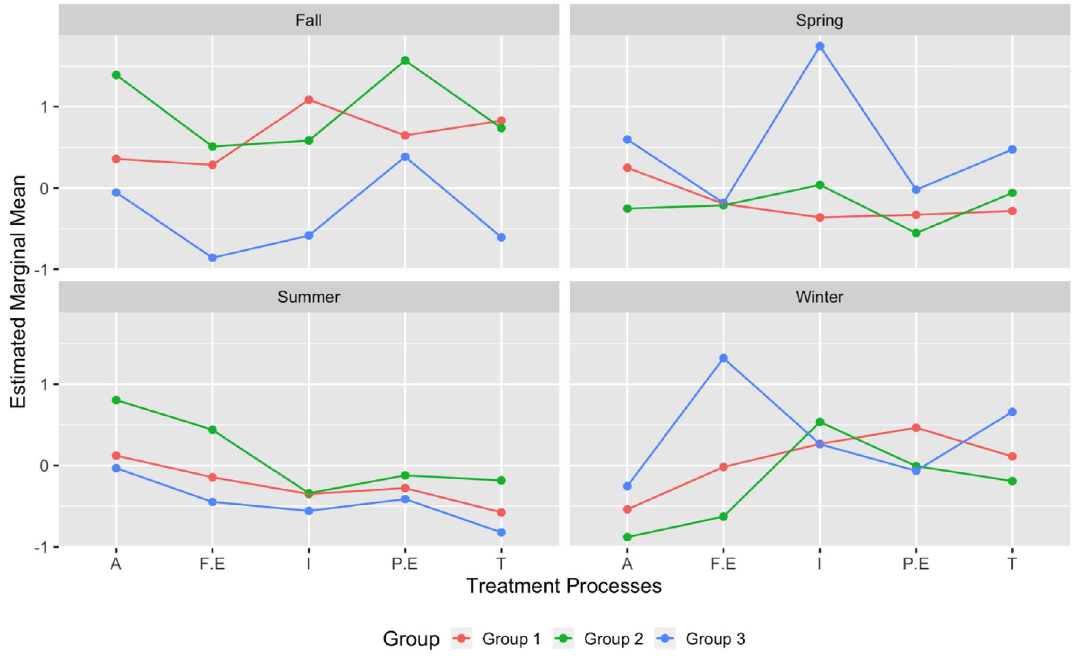
Fig. 4 The results from LMEM to construct three-way